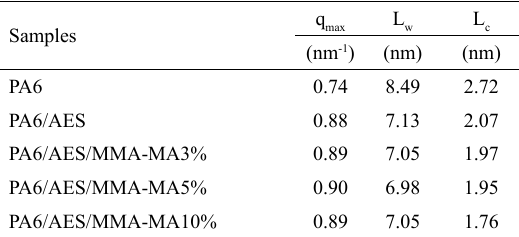
Table 3. Calculated data from SAXS measurements of PA6, PA6/ AES and blends compatibilized with MMA-MA synthetized with different MA